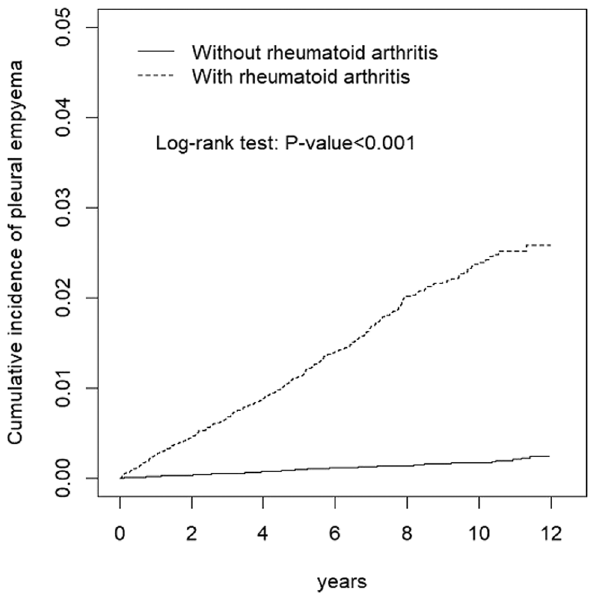
Figure 1: Cumulative incidence of empyema between individuals with and without rheumatoid